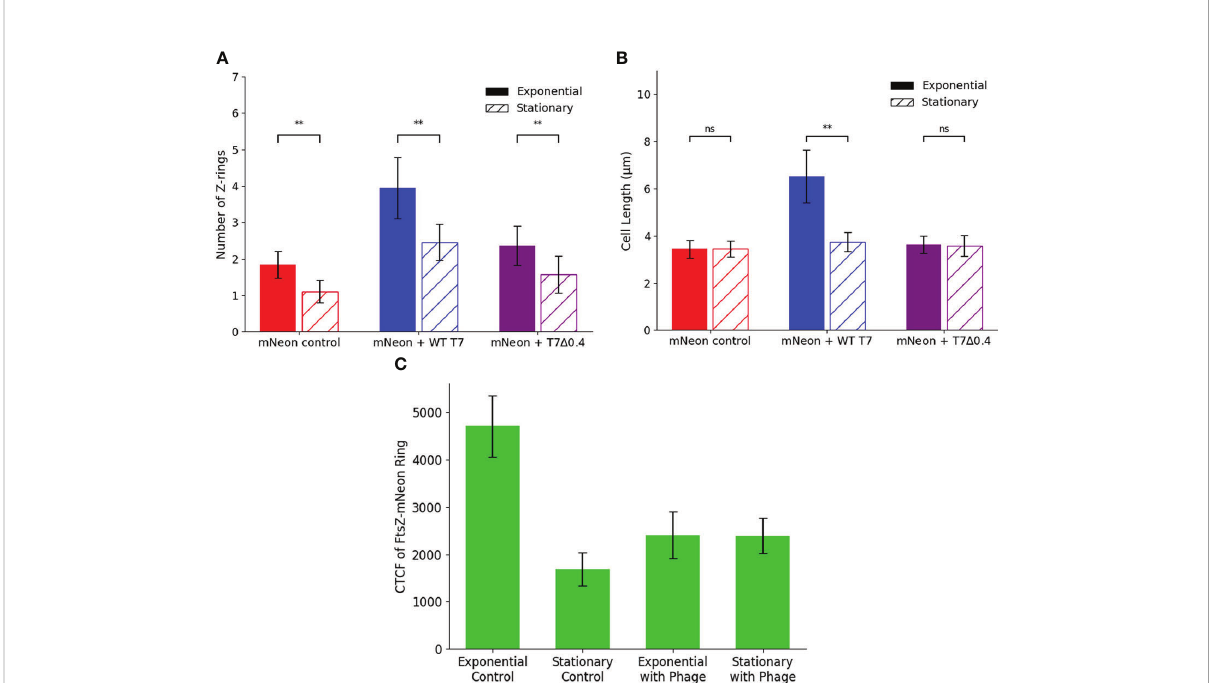
FIGURE 8 Stationary phase microscopy quanti fi cation of WT T7 and T7 D 0.4 infection. Quanti fi cation of (A) Z-ring number and (B) cell length for 75 K12/FtsZ-mNeon bacterial cells infected with T7-mCherry or T7 D 0.4 phage during the stationary phase of growth, along with a no-phage control, compared to exponential phase data. Tukey ’ s tests were performed, and the calculated probability values (p-values) are displayed as p < 0.05 (*), p < 0.01 (**), and not statistically signi fi cant p > 0.05 (ns). (C) Exponential phase control, stationary phase control, exponential phase with T7 phage, and stationary phase with T7 phage cultures of Escherichia coli K12/FtsZ-mNeon imaged on agarose pads, and the corrected total cell fl uorescence (CTCF) of 50 Z-rings per sample was averaged and plotted. Error bars show one standard deviation of uncertainty ns, not signi fi